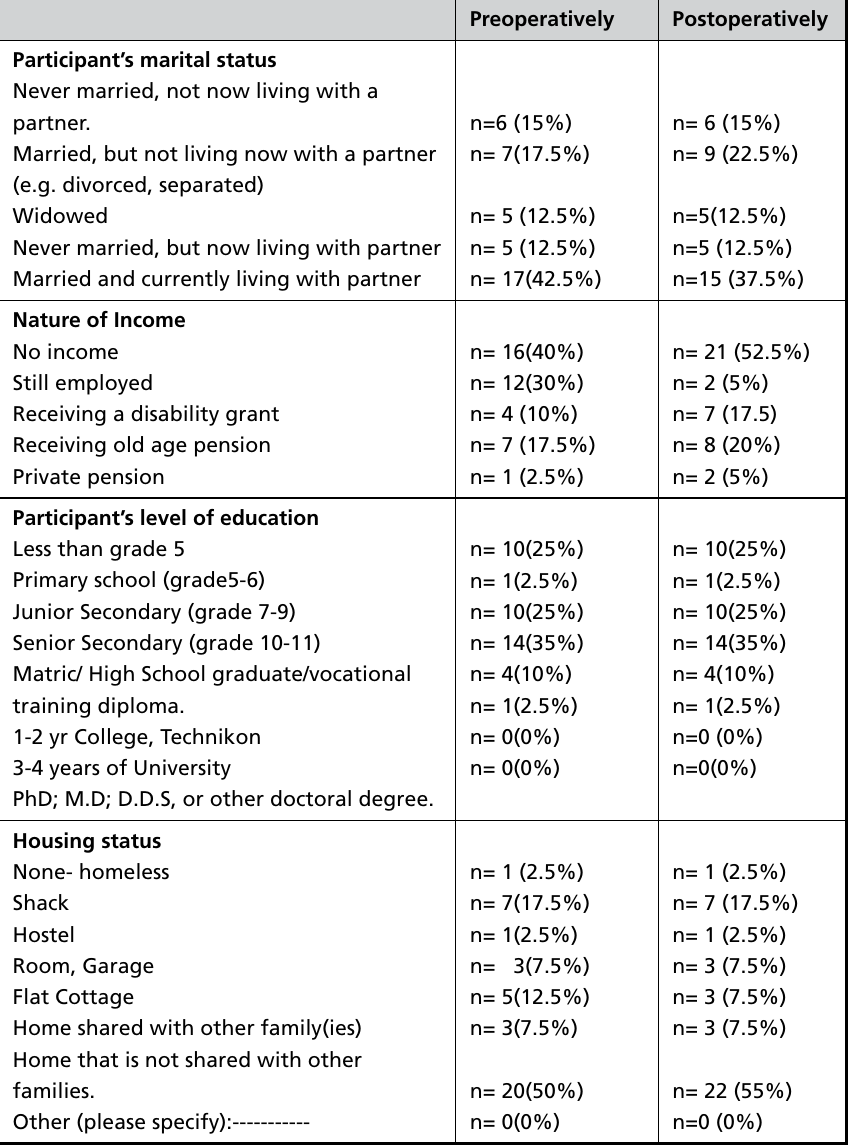
Table 4: Household economic and social status (n=40)